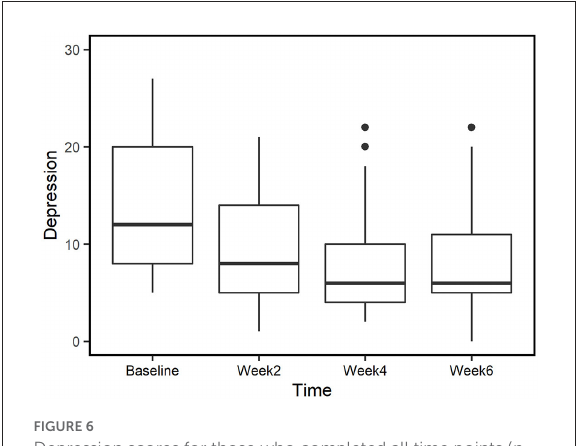
FIGURE6 Depression scores for those who completed all time points ( n = 29). Median values are represented by horizontal black lines in the box